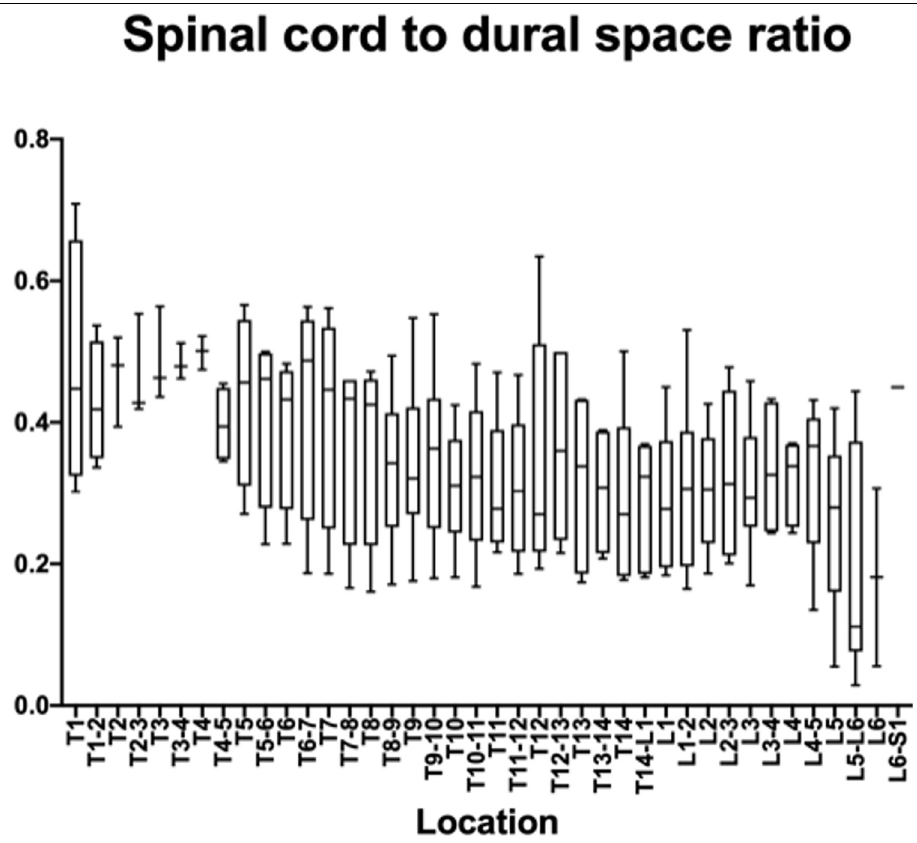
Fig 9. Graph of the spinal cord to dural space ratio in 6 Yucatan sows. The median, 75 th , 25 th percentile and the range are shown for each thoracolumbar vertebral